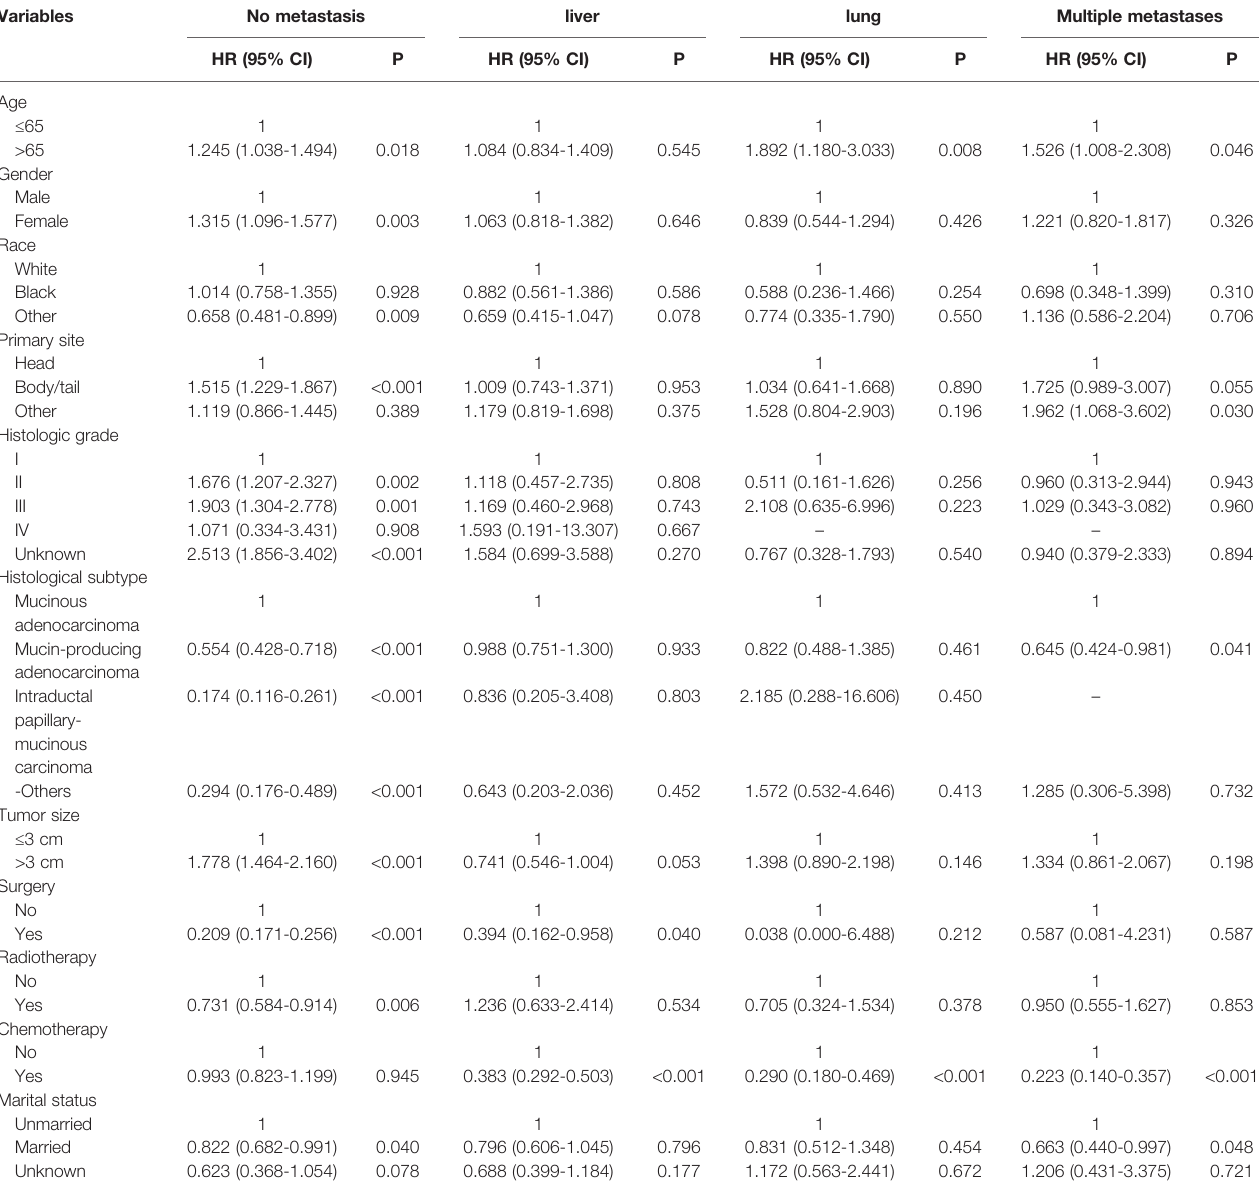
TABLE 2 | Univariable Cox regression analysis of cancer-speci fi c survival in patient with IPMN with associated invasive carcinoma. Variables No metastasis liver lung Multiple